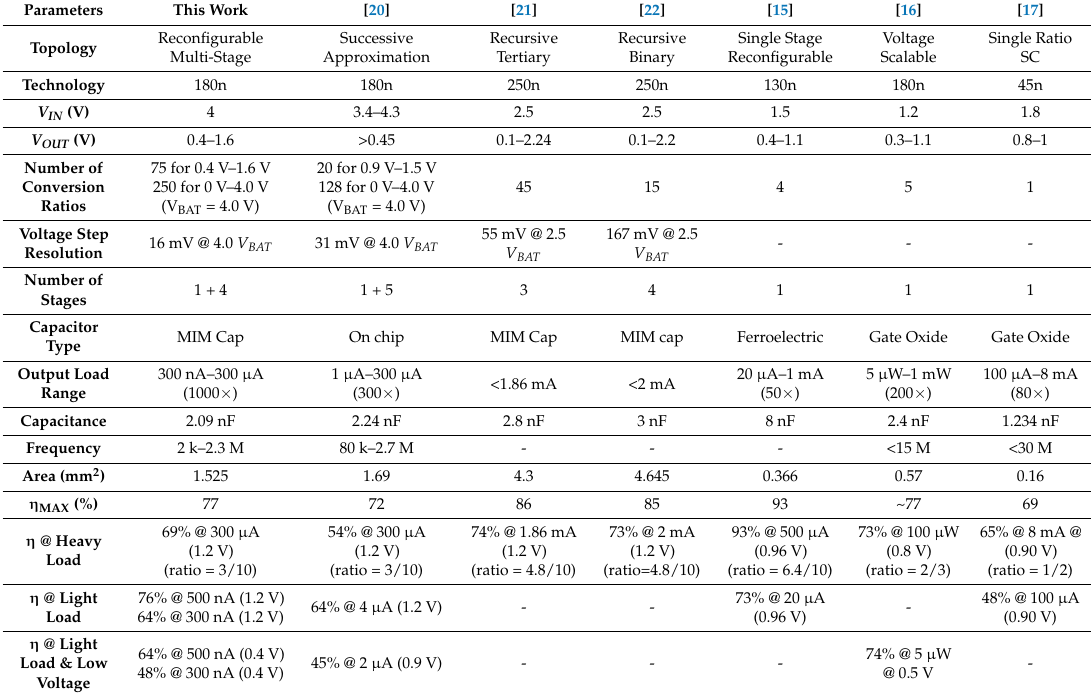
Table 4. Performance comparison with prior SC